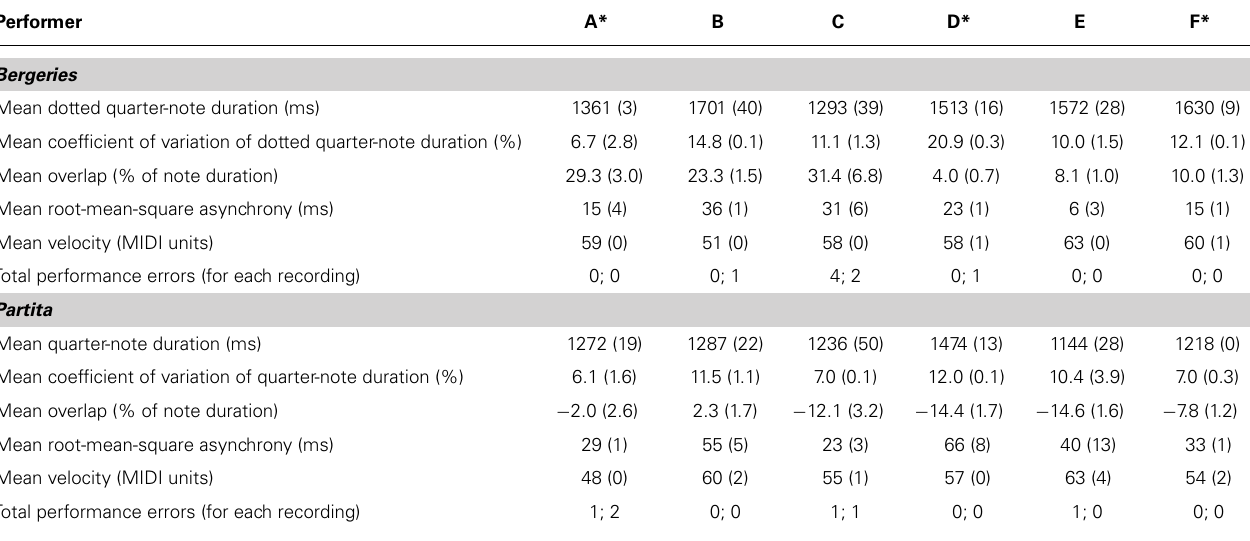
Table 1 | Mean values for the expressive parameters and total performance errors for each performer. Performer A* B Bergeries